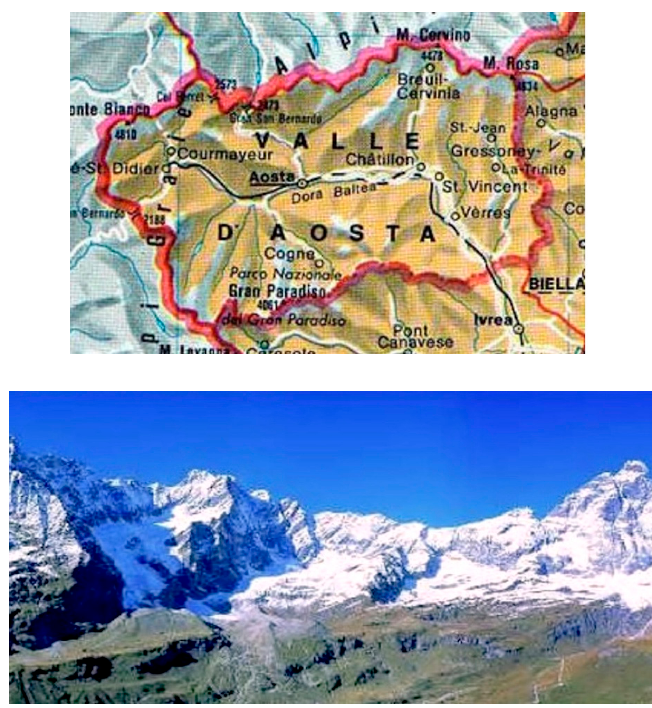
Figure 5. The Valtournenche Valley with the Matterhorn (or Mount Cervino) in the